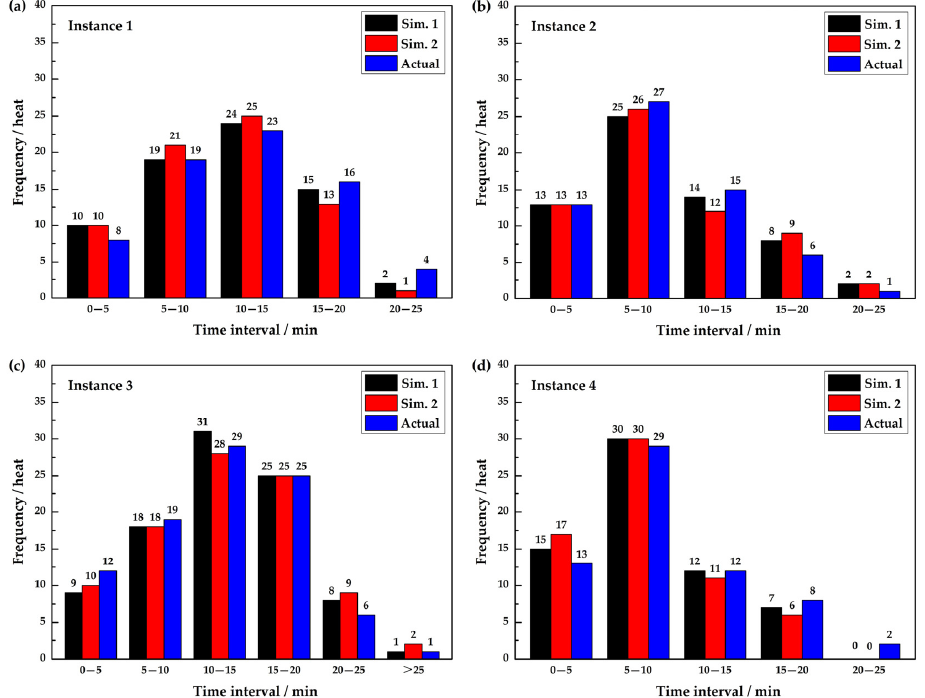
Figure 10. Distributions on the transfer times of heats from BOF to LF. Metals 2019 , 9 , 1078